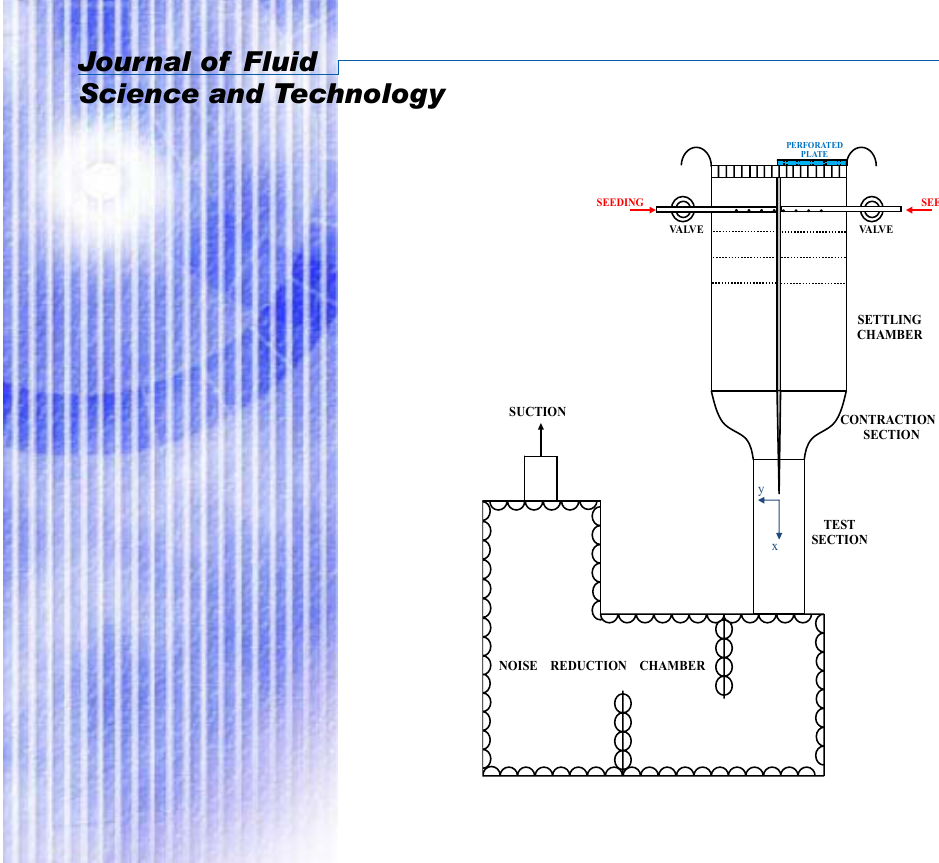
Figure 2 Schematic of experimental wind